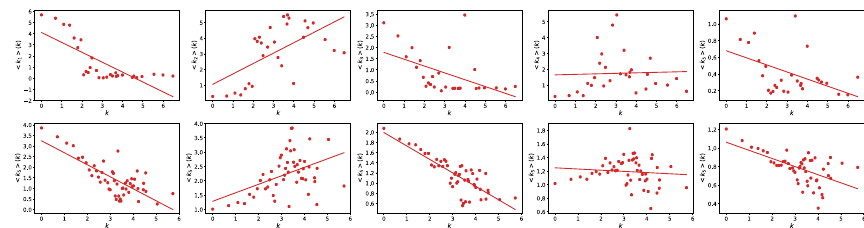
Fig. 21 Degree correlations of two fractal social networks at distances from 1 to 5. (cid:31) k m (cid:30) ( k ) is plotted against k on a log‑log scale, and the line fitted to the log‑transformed data is also